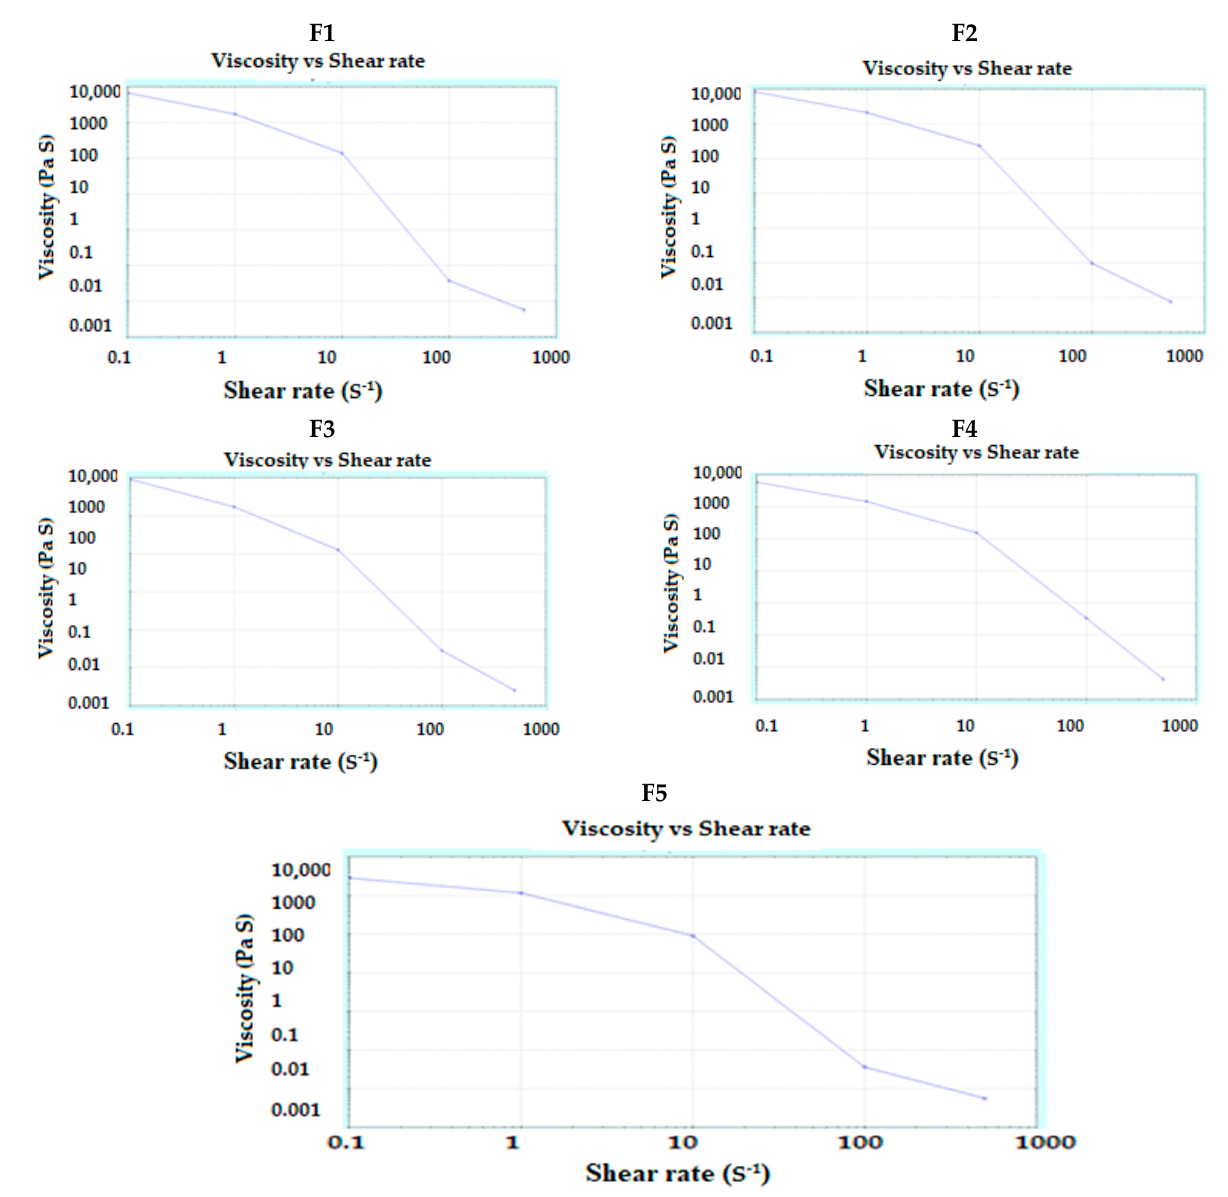
Figure 1. Rheograms of the prepared pastes ( F1 – F5 ) used in